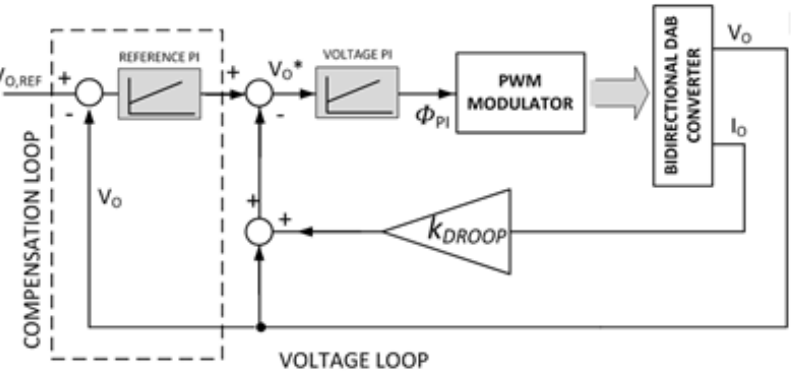
Figure 17. Block diagram illustration of the voltage-droop control with reference compensation protocol.